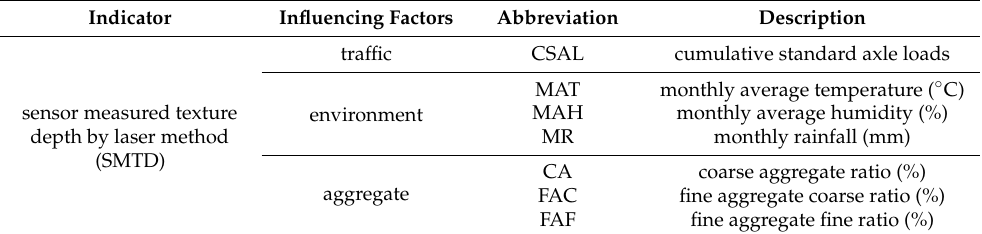
fine aggregate fine ratio